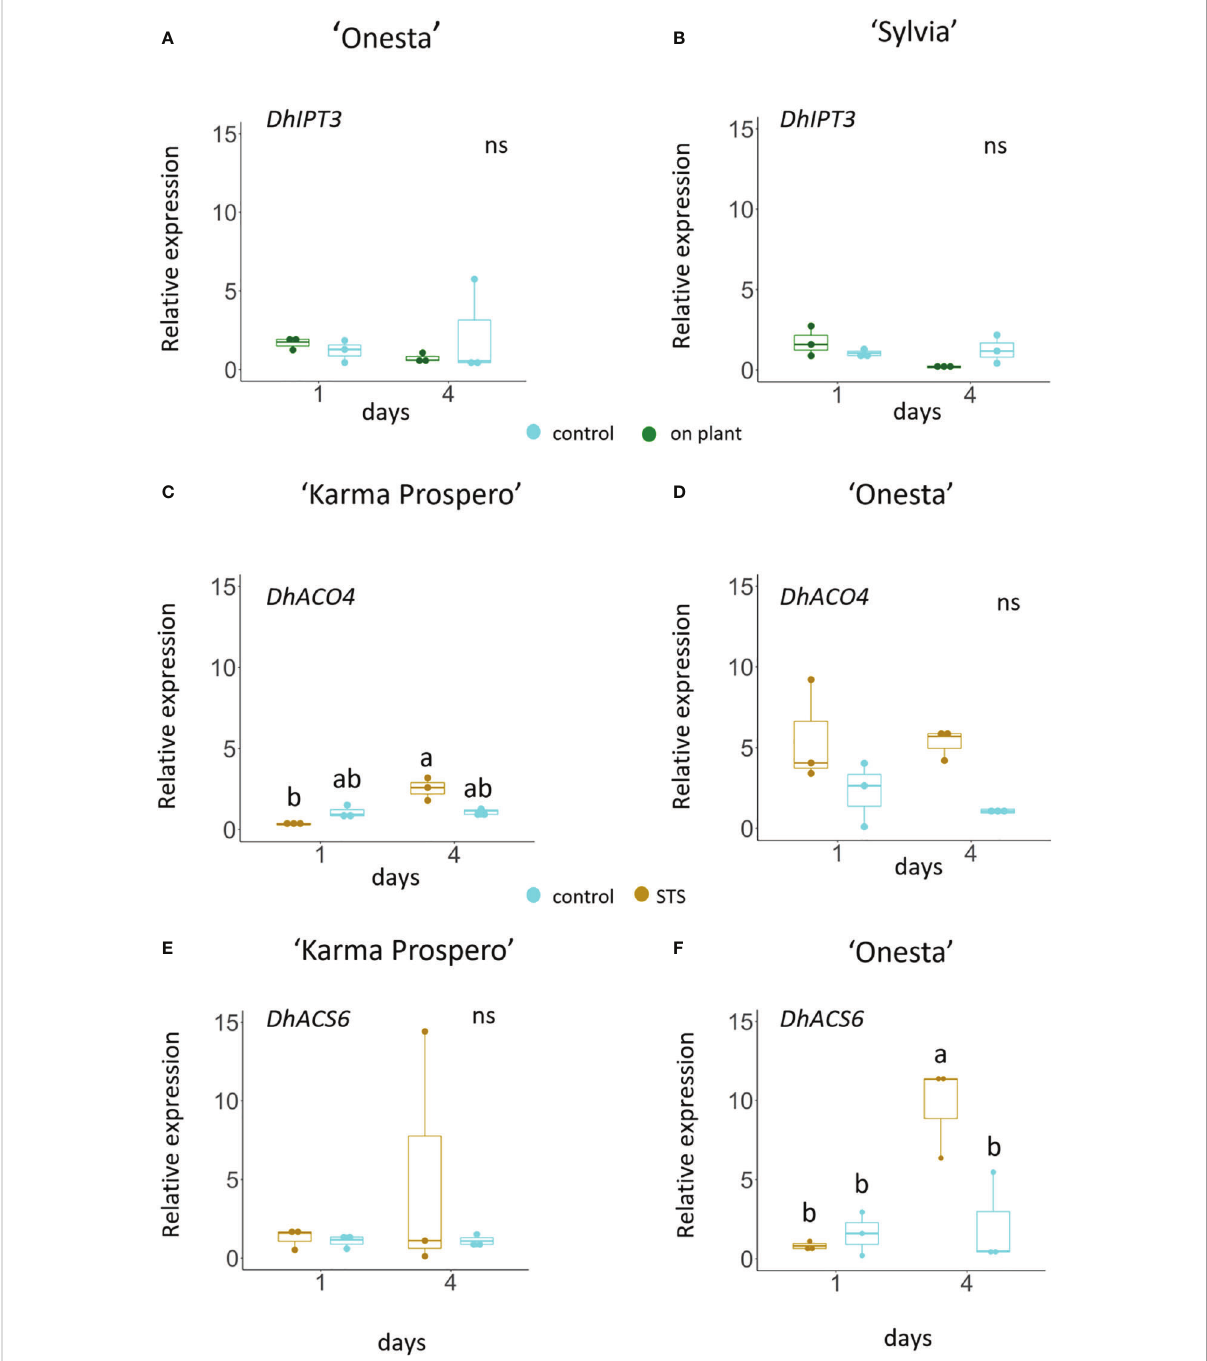
FIGURE 11 Relative gene expression (by RT-qPCR) in dahlia fl orets 1 and 4 days after harvest at Stage III: Dp IPT3 (A, C) DpACO4 (C, D) and DpACS6 (E, F) in ‘ Onesta ’ (A, D, F) Sylvia ’ (B) ‘ Karma Prospero ’ (C, E) from fl owers treated as controls (distilled water) or compared to fl owers left on the plant (A, B) a 1 h pulse of 4 mM STS (C – F) , using b -tubulin as a reference (n=3). Different letters indicate signi fi cant differences ( p < 0.05) amongst the four samples for each panel based on ANOVA followed by a Tukey ’ s